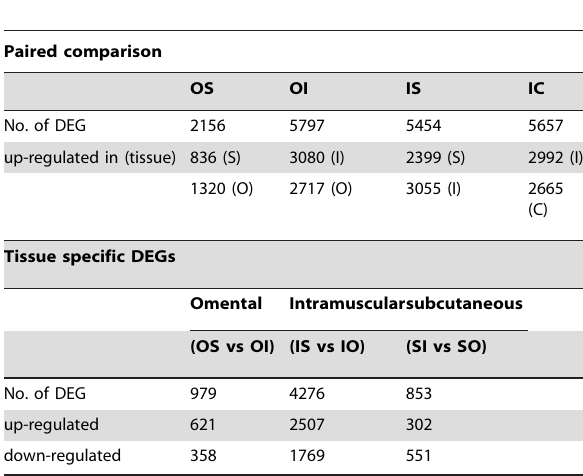
Table 1. Summary of DEG identified from the comparison among three different adipose tissues (FDR ,